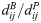
Costs of different terms corresponding to different dijB/dijP.